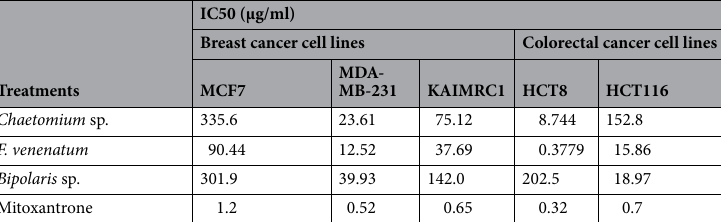
Table 2. The half-maximal inhibitory concentrations (IC 50 ) of fungal extracts for the five human cancer cell lines.